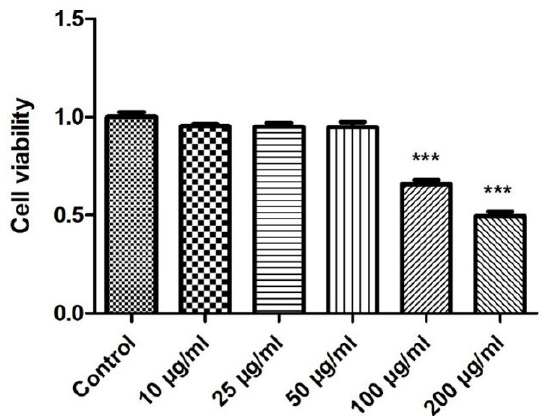
Figure 2. Water-soluble tetrazolium salt (WST) assays were used to detect hDPSC viability on exposure to L-15 extract ( n = 3). Error bars represent mean ± S.D. *** p < 0.01, one-way ANOVA followed by Dunnett’s post hoc test was used.